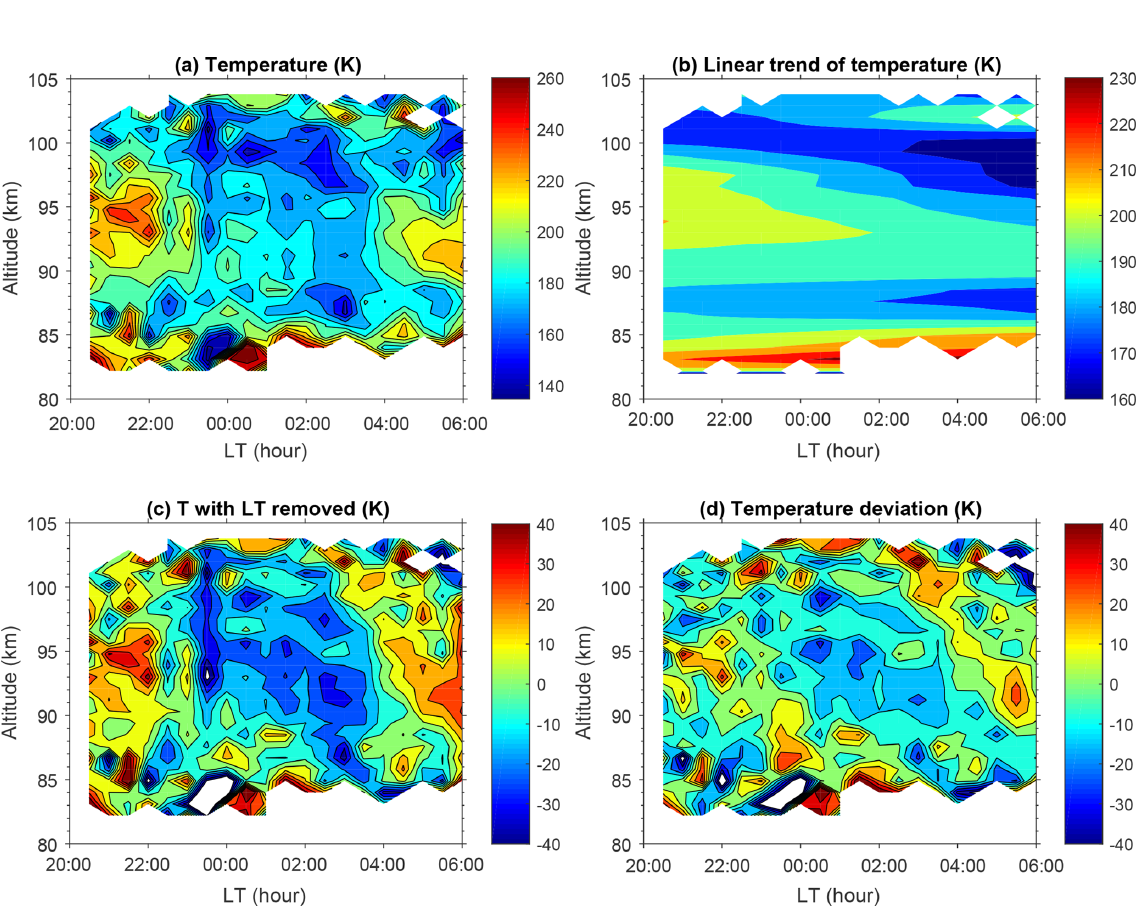
Figure 2. Illustration of data processing for temperature on 18 December 2003: (a) K lidar-measured temperature with 0.9km and 30min vertical and temporal resolutions, respectively; (b) linear trend of temperature in time; (c) temperature perturbations after removing the linear trend in time; and (d) temperature perturbations after removing the linear trend in time and the vertical